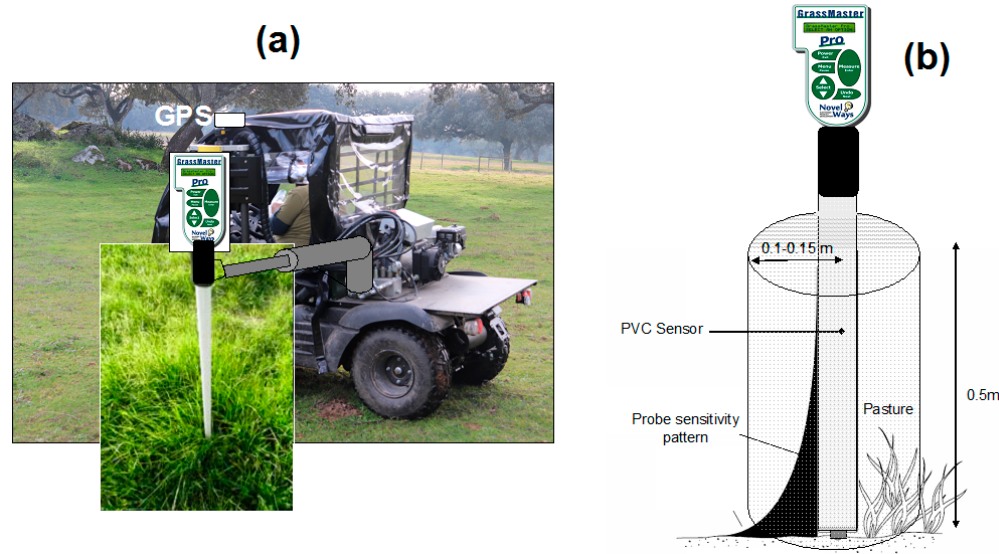
Figure 11. ( a ) Desirable development of Grassmaster probe device: portability and georeferencing; ( b ) probe sensitivity pattern.